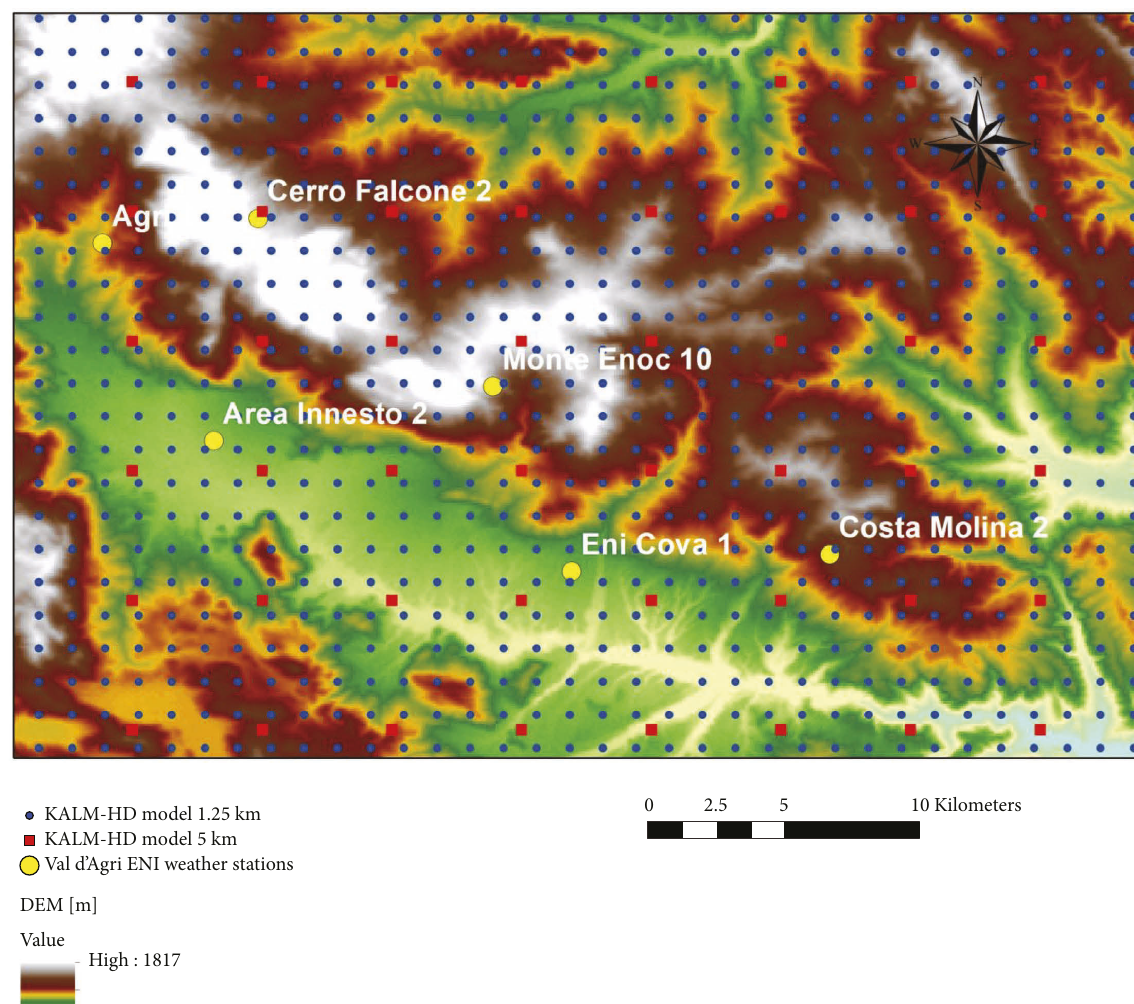
Figure 3: The two horizontal grid resolutions of the meteorological model KALM-HD at 1.25km (blue dots) and 5km (red squares). The six weather stations (yellow dots) used in the benchmark analysis are represented in the figure as